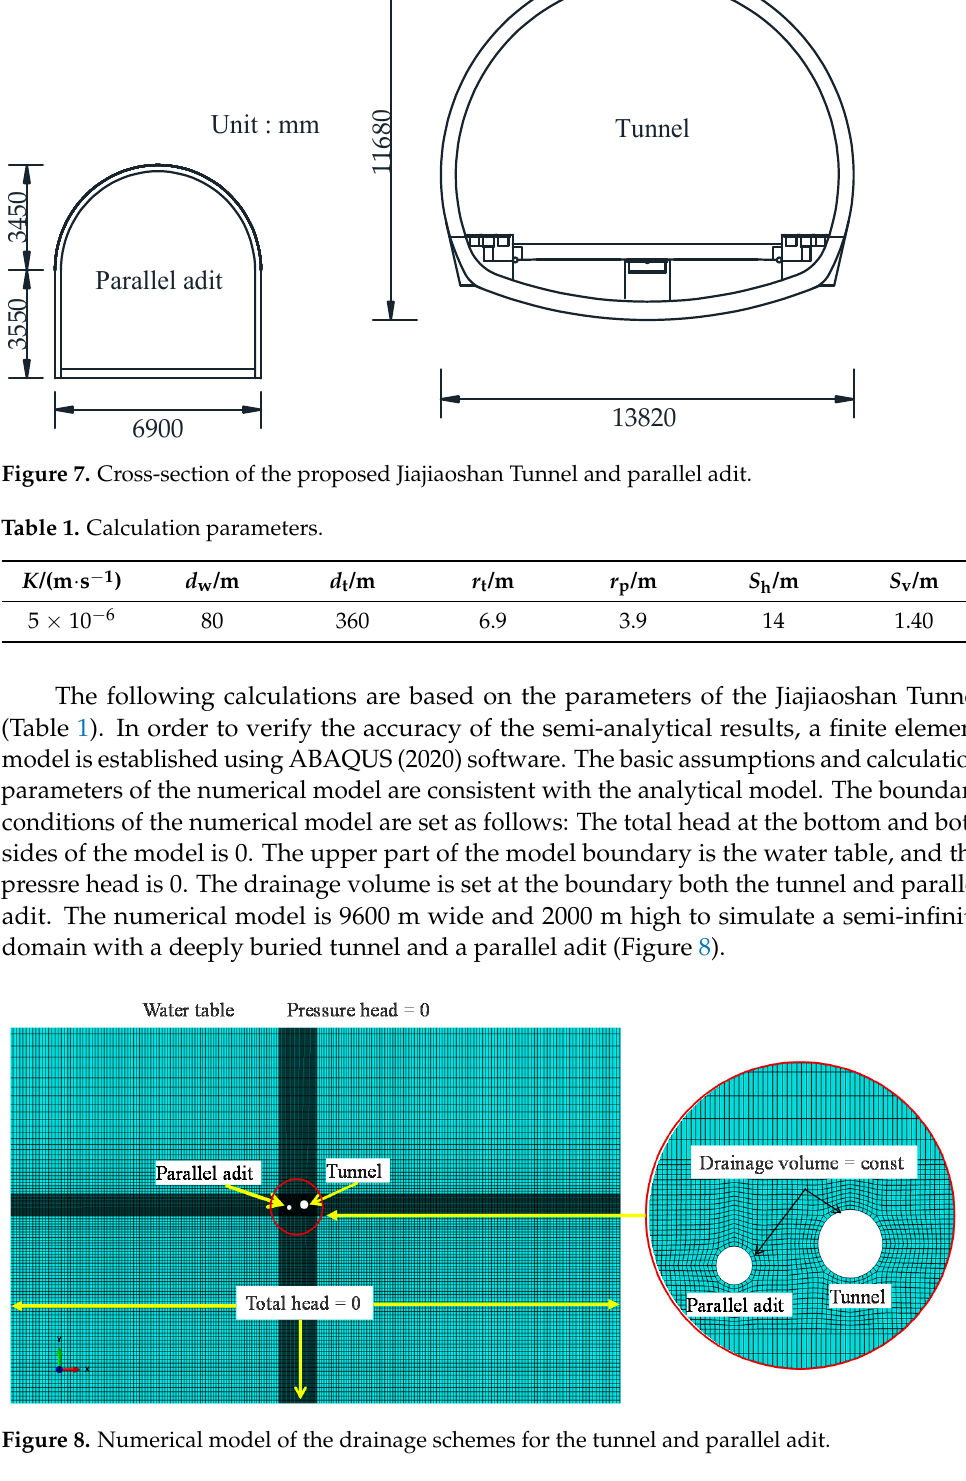
Figure 8. Numerical model of the drainage schemes for the tunnel and parallel adit.